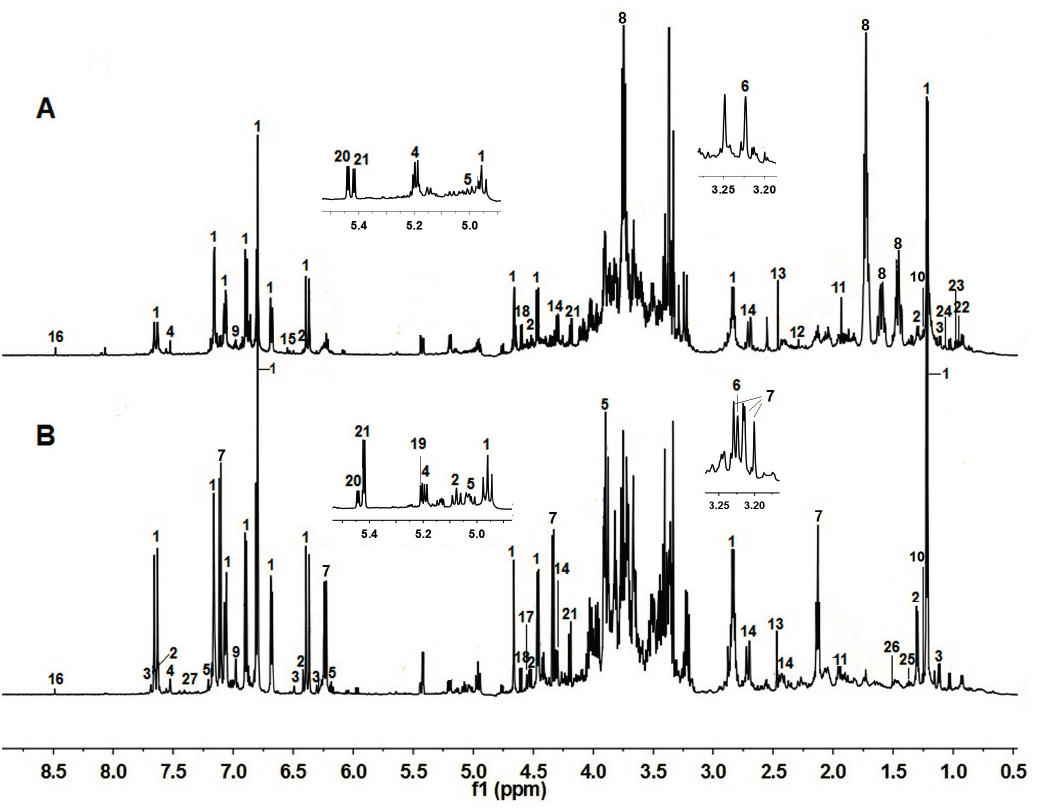
Figure 1. Typical 1 H-NMR spectra (600 MHz) from aqueous methanol fractions of RF ( A ) and GF ( B ). The numbers correspond to the metabolites in Table